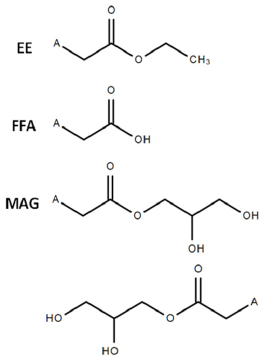
Figure 2. The chemical structures of the OM3: ethyl ester, free fatty acid and sn-1(3)- monoacylglycerol products. A = fatty acid (e.g., EPA,